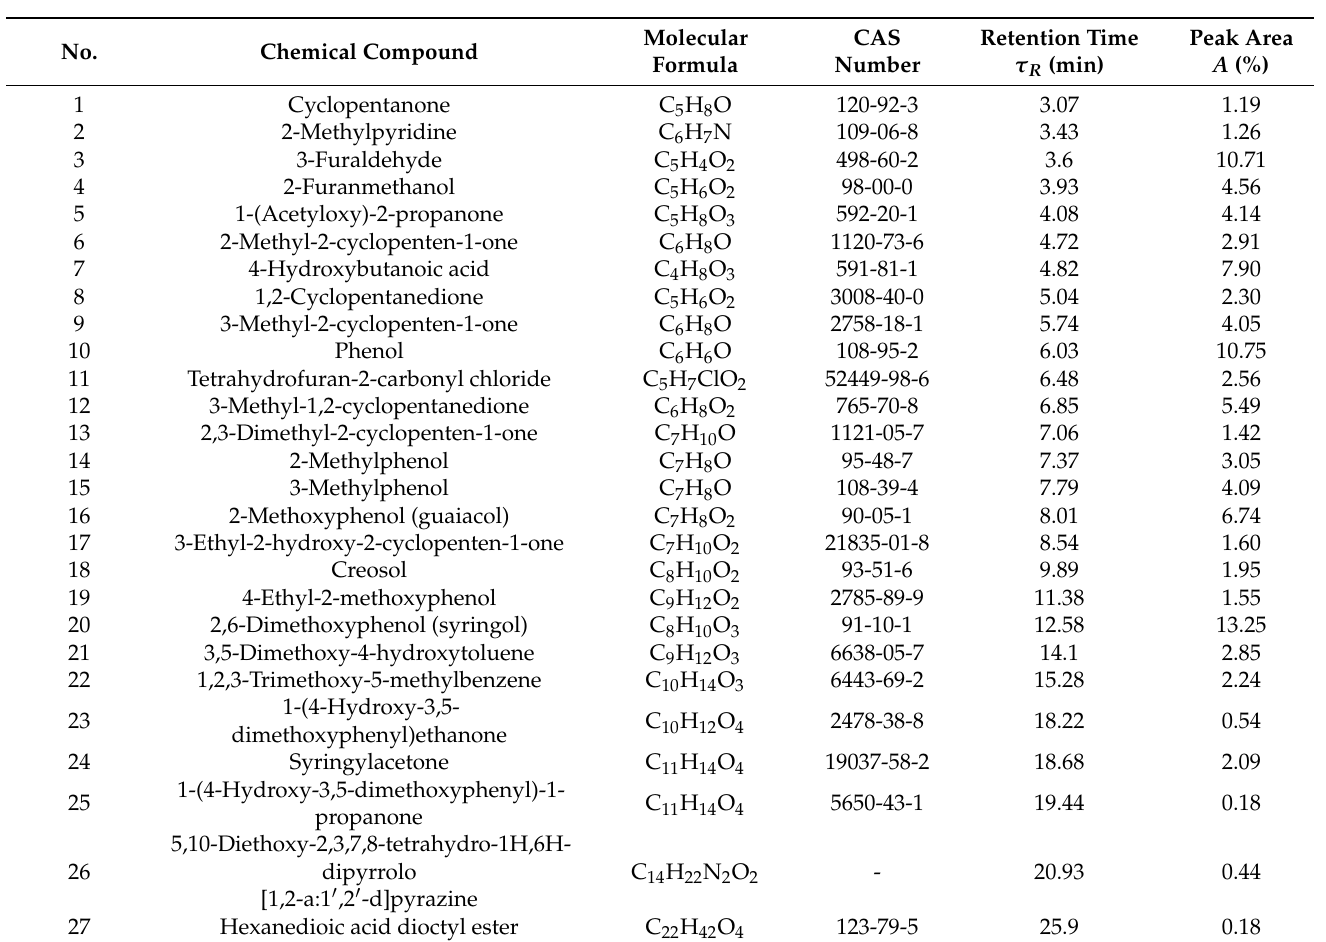
Table 4. Chemical composition of